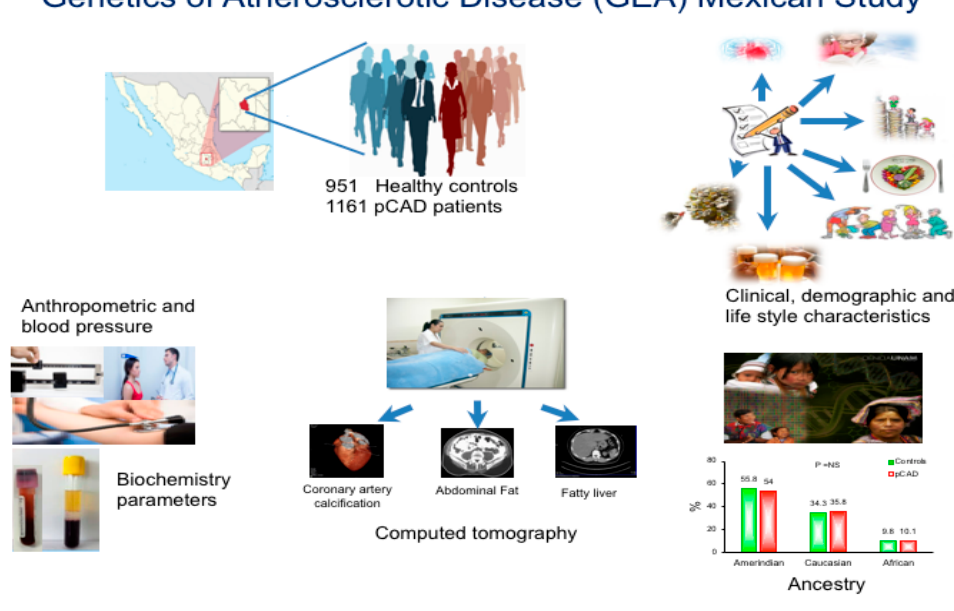
Figure 1. Study design and methodology.